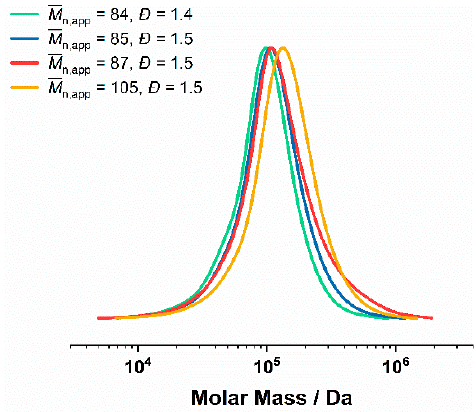
Figure 5. GPC of P(DMA- co -NIPAM)- b -PS synthesized via RAFT emulsion polymerization in water/1,4-dioxane 80:20 (20% w/w ) using either the P(DMA 29 -NIPAM 180 ) 24 or P(DMA 35 -NIPAM 212 ) 28 as mCTA. The M n,app (determined by DMAc GPC calibrated with PS standards) and the dispersity of the respective GPC curve are shown in the legend.